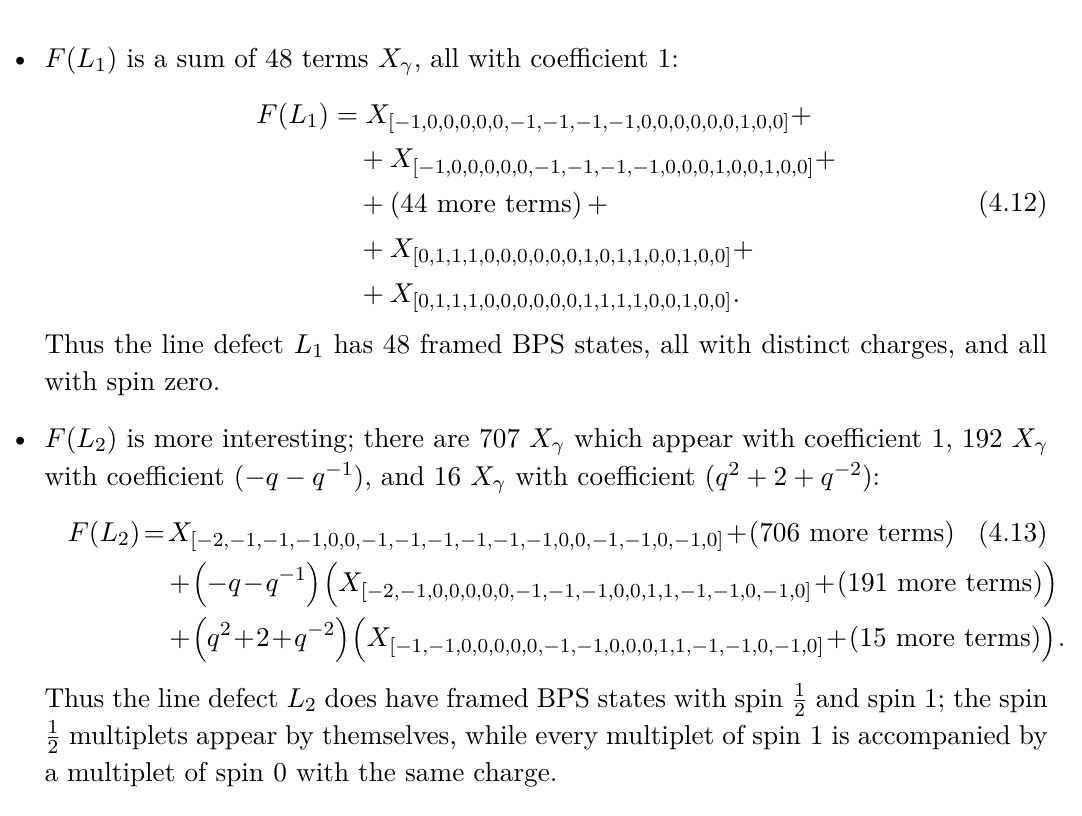
Figure 50 . Three 1 -cycles γ A , γ B , γ C on the triple cover e C